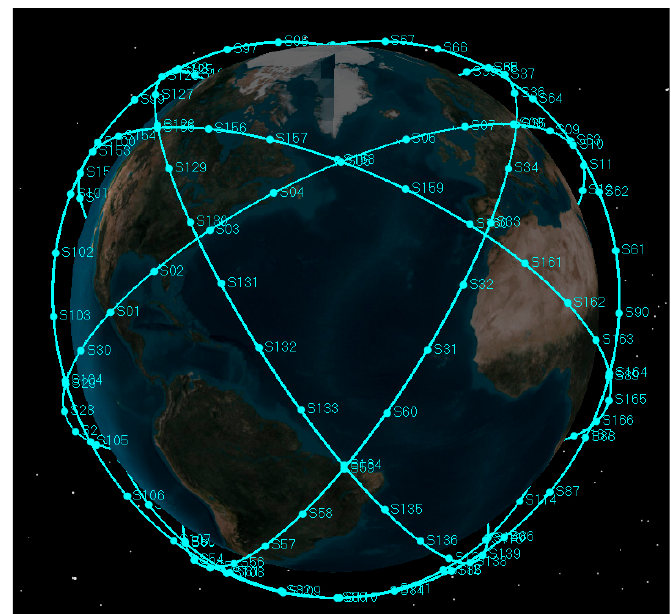
Figure 7. Satellite constellation in the simulation scenario. The parameters for the integrated navigation simulation are listed in Table 1. Table 1. Basic simulation configuration.